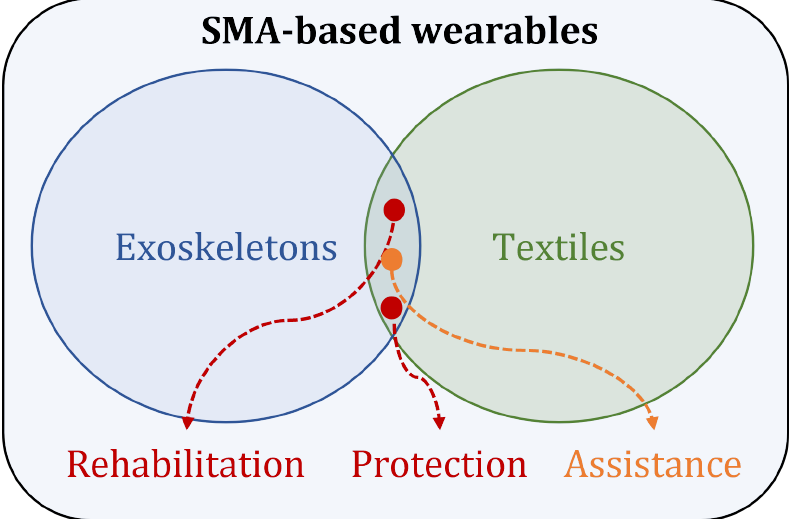
Figure 4. The major application domain of SMA-based wearables can be found in exoskeletons and textiles for either rehabilitation or